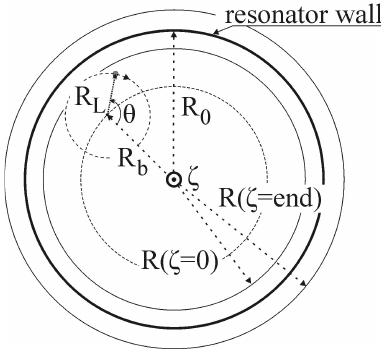
Figure 2. Resonator cross